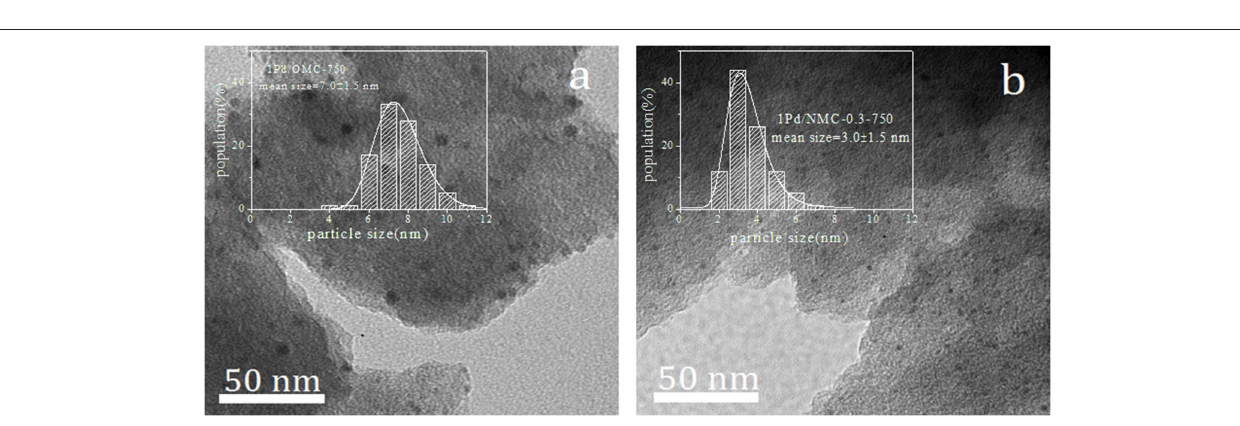
XPS spectra can be deconvoluted into two peaks, namely, C = O (532.6 ± 0.1 eV) and C–OH (533.8 ± 0.1 eV). Figure 7D shows the fitting results of the XPS pattern of Pd 3d. The fitted peak of Pd 3d can be divided into two groups in which a set of characteristic peaks at 340.9 and 335.9 eV can be assigned to